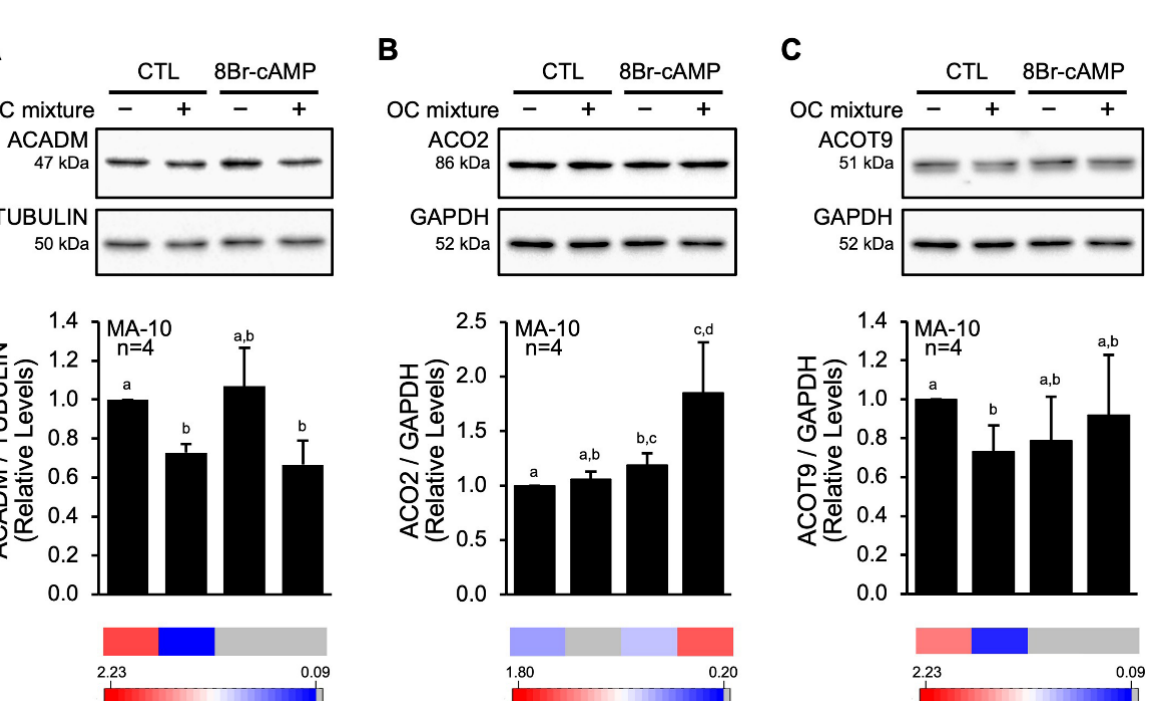
Figure 6. The OC mixture affects protein levels in MA-10 Leydig cells. MA-10 Leydig cells were treated with either dimethylsulfoxyde ( − ) or 10 µg/mL of an environmentally relevant mixture of OCs (+) for 2 h and then treated for another 4 h without (CTL) or with 0.1 mM 8Br-cAMP as indicated. ACADM ( A ), ACO2 ( B ), and ACOT9 ( C ) proteins were detected by Western blot. α TUBULIN or GAPDH were used as loading controls. The experiment was repeated four times, and the results from each experiment were quantified and are plotted as mean ±SE of the mean. Different letters indicate a statistically significant difference between groups ( p < 0.05). The relevant line from the heatmap analysis (Figures 4 and 5) is shown under the graph.